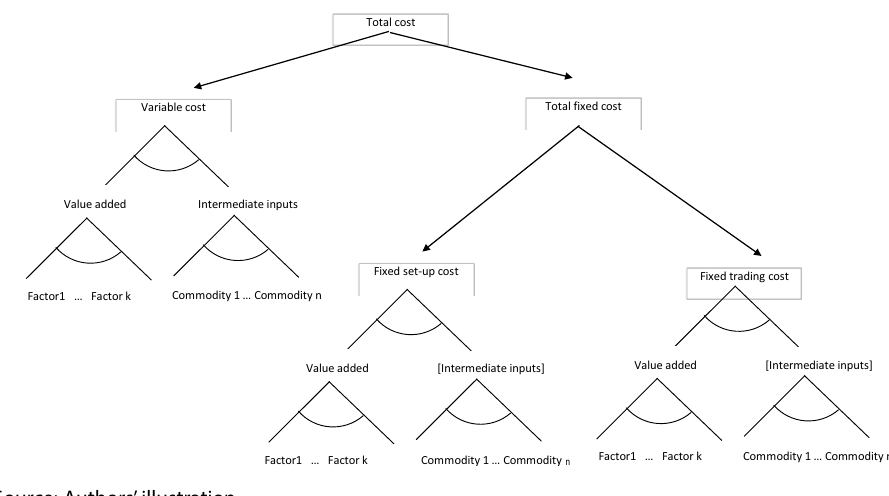
Figure 1. Production structure in Melitz